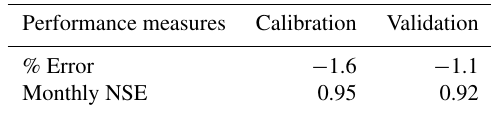
Table 4. Results of SWAT calibration and validation for monthly